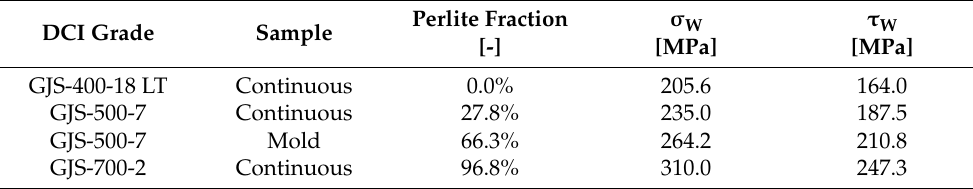
Figure 6. Linear approximation of the ratio of the ratio of the axial fatigue strength over the tensile strength as a function of the pearlite fraction in the matrix. Table 5. Axial and torsional fatigue strength of each sample.